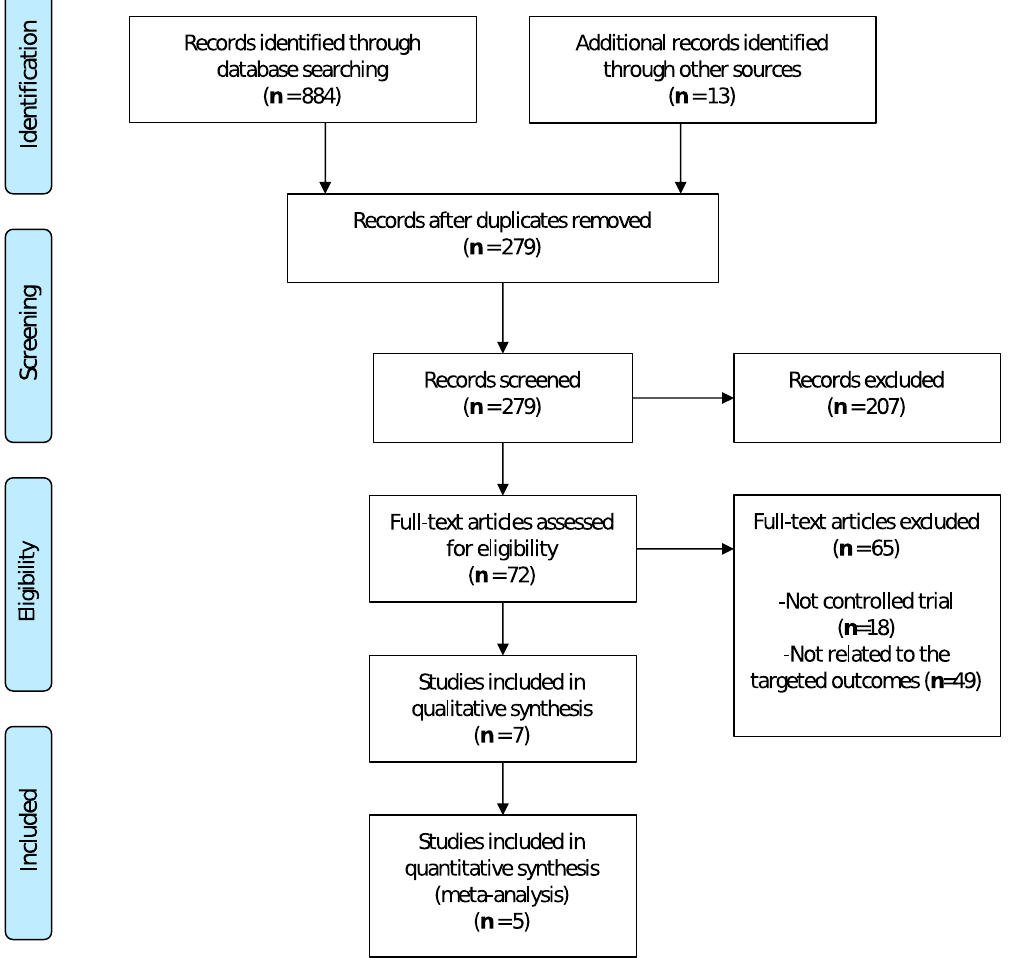
Figure 1. Flow diagram of the different phases of the systematic review and meta-analysis. Table 1. Scores obtained after methodological evaluation according to the Physiotherapy Evidence Database (PEDro) scale.